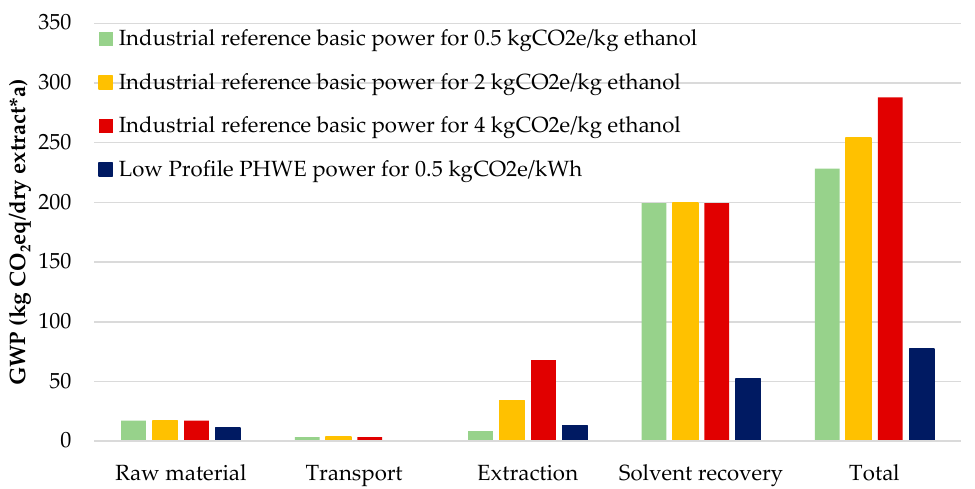
Figure 14. Dependence of extraction processes on the direct CO 2 emissions of solvent production.